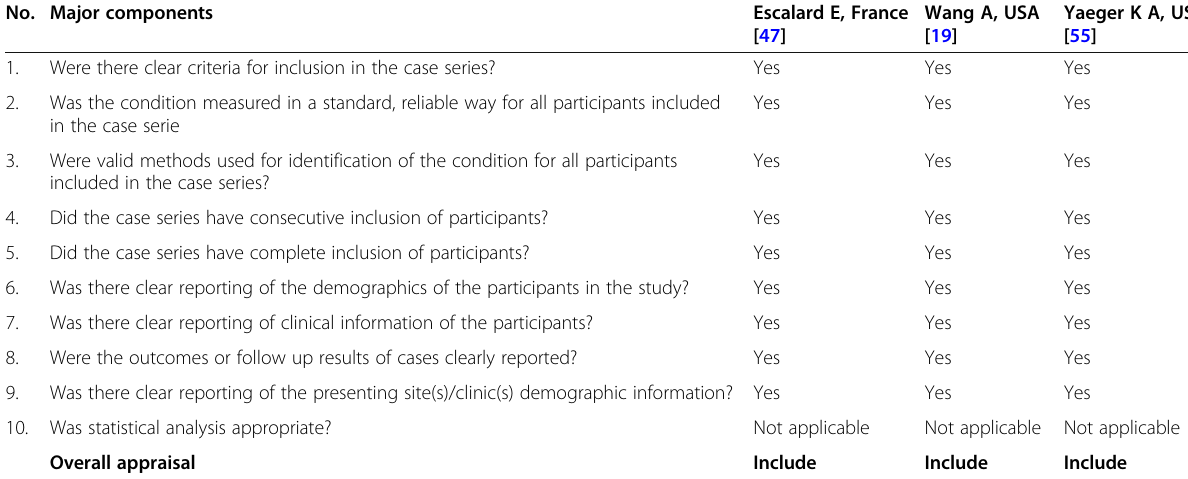
Table 5 JBI Critical Appraisal Checklist for case series No. Major